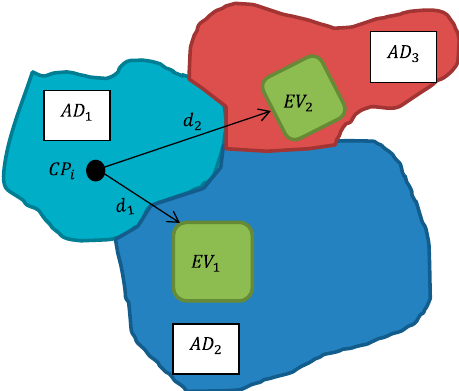
Figure 2. Conceptual framework of distance matrix to green spaces in Dissemination Areas. AD = Dissemination Area; EV = Green Space; CP is a six-digit postal code; d 1 and d 2 are weighted distances from a postal code to the boundary of a green space.